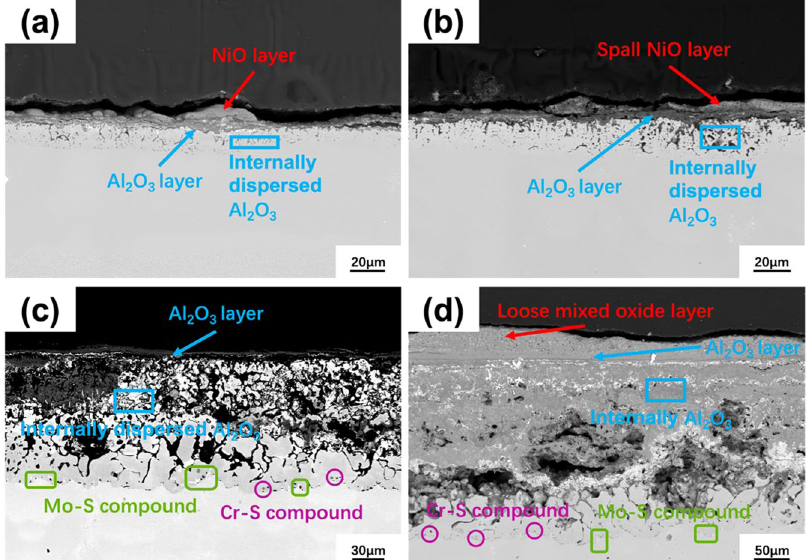
Fig. 8 The cross-section morphologies of the surfaces near the holes after different hot corrosion time at 900 °C. a 20 h, b 50 h, c 100 h, and d 200